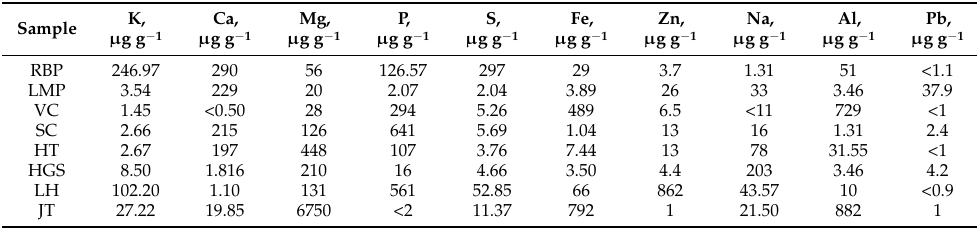
Table 4. Composition of HS in the studied samples (W = mass fraction). (See Table 1 for sample name abbreviation